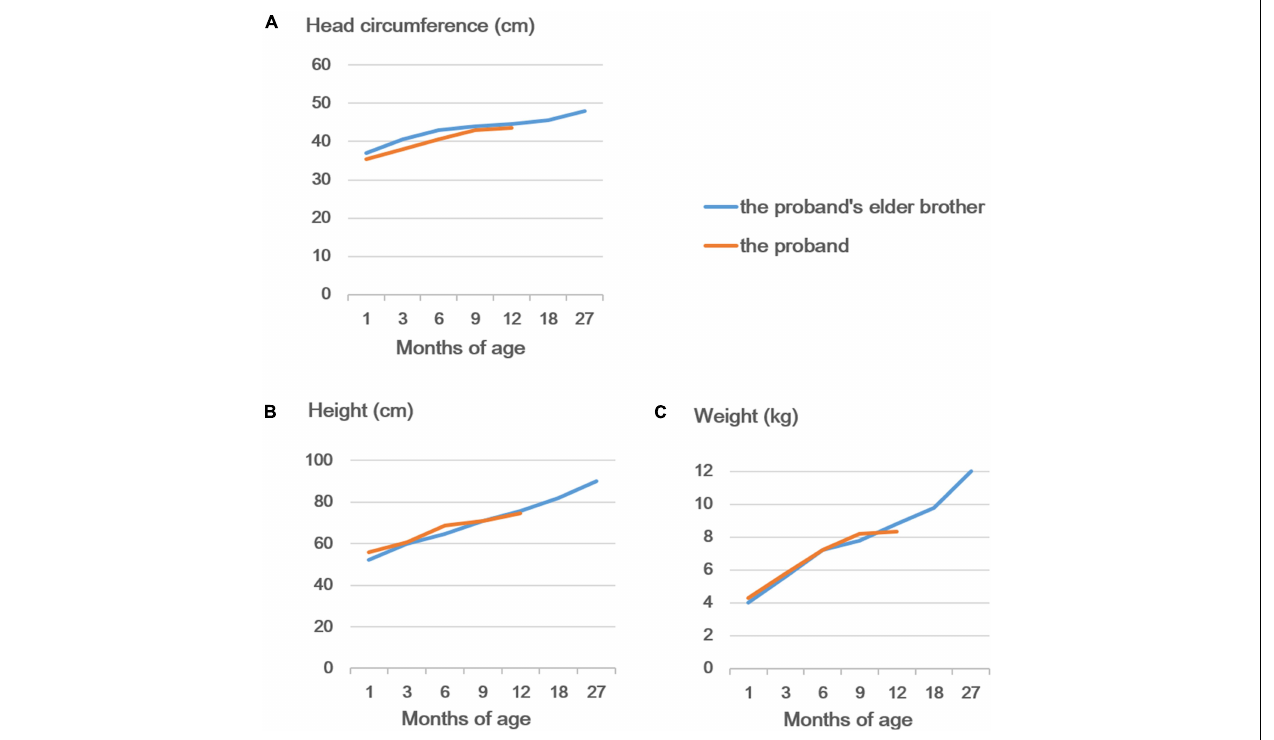
FIGURE 4 | Developmental curves of the head circumference (A) , height (B) , and weight (C) of the proband and his elder